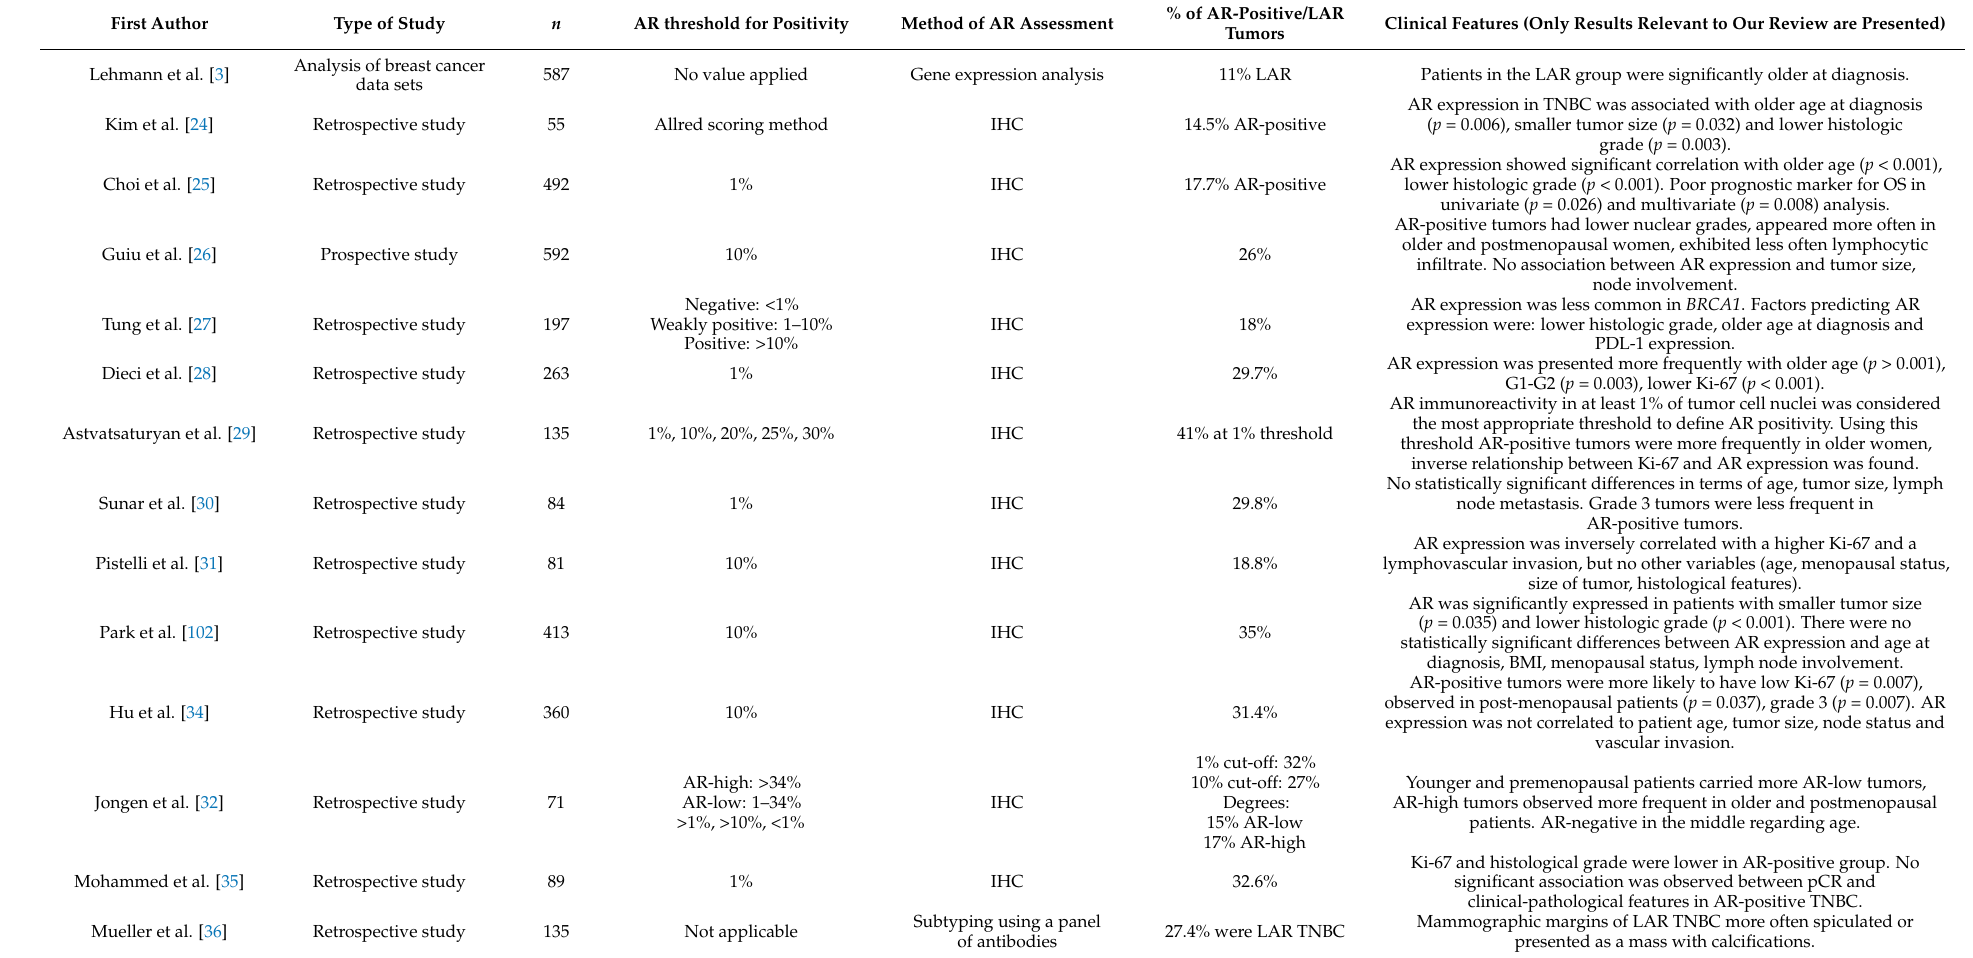
Table 1. Table is representing major studies investigating clinical-pathological features of AR-positive triple-negative breast cancer (TNBC) and luminal androgen (LAR)